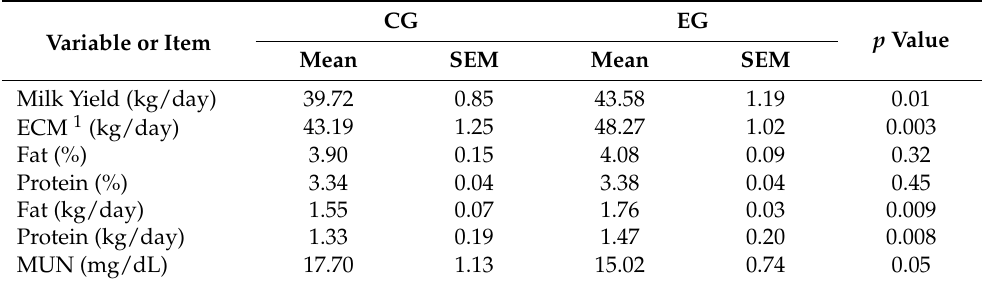
Table 3. Mean values ± SEM for milk yield and milk constituents of dairy cows grouped by low (CG) or high (EG) locomotion score.